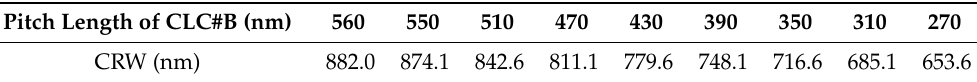
Figure 5. Simulated reflection spectrum of single-pitch CLCs with 20 turns of CLC helix, and the pitch length and the n o / n e of the CLCs are 560 nm and 1.5 / 1.65, respectively. Table 2. Values of λ cen of 882, 874.1, 842.6, 811.1, 779.6, 748.1, 716.6, 685.1, and 653.6 nm approximately fit the CRWs that are shown in Table